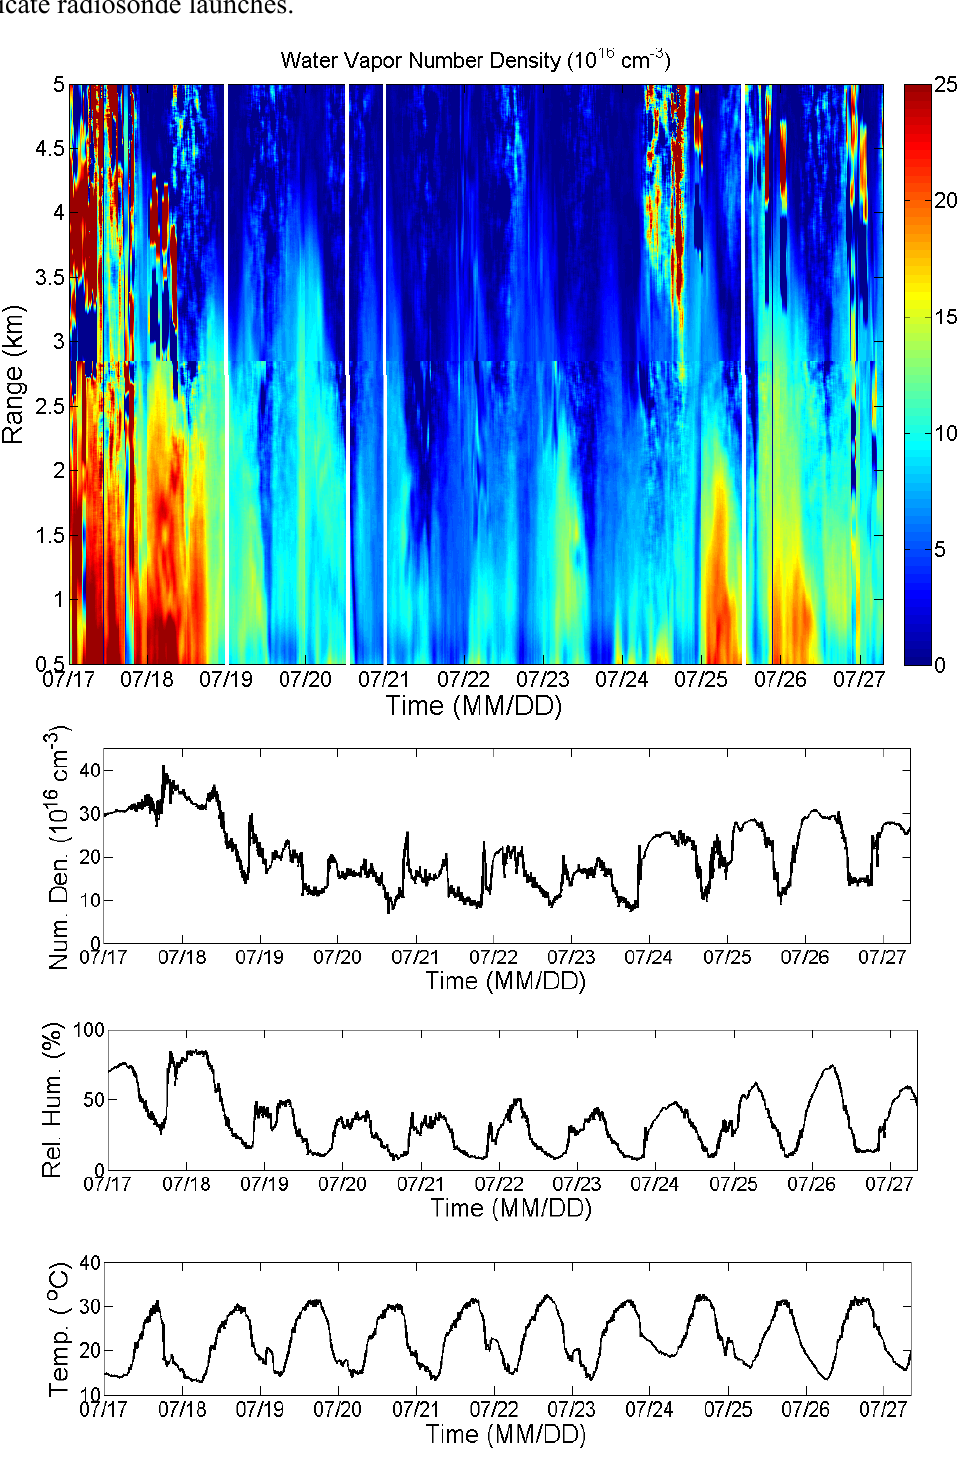
Figure 6. The water vapor number density as a function of range and time is shown in the top plot while the number density, relative humidity, and temperature measures at the surface are shown in the bottom three plots. The solid white vertical lines in the top plot indicate radiosonde